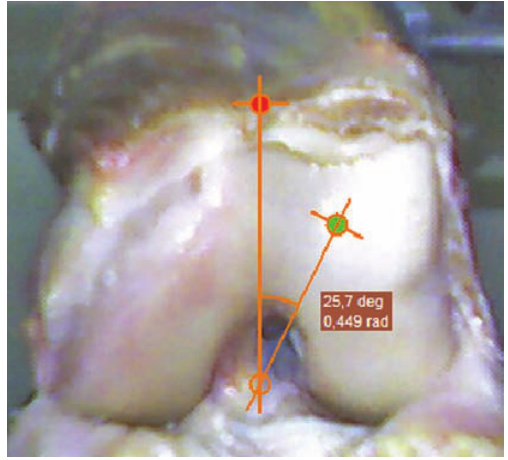
Figure 6 - Femoral tunnel angular position in the notch. The angle was measured with